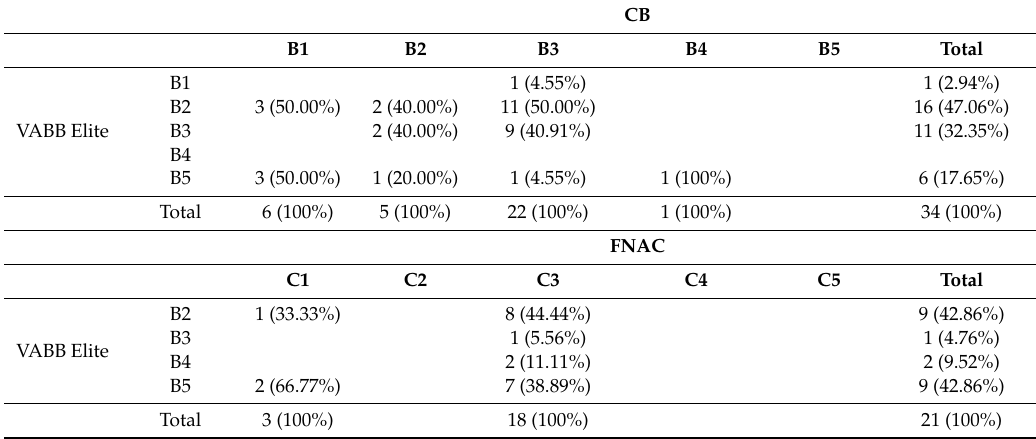
Table 4. Results of the Elite VABB procedure compared to the CB (34 patients) and fine-needle aspiration cytology (FNAC) (21 patients) procedures of patients who underwent both